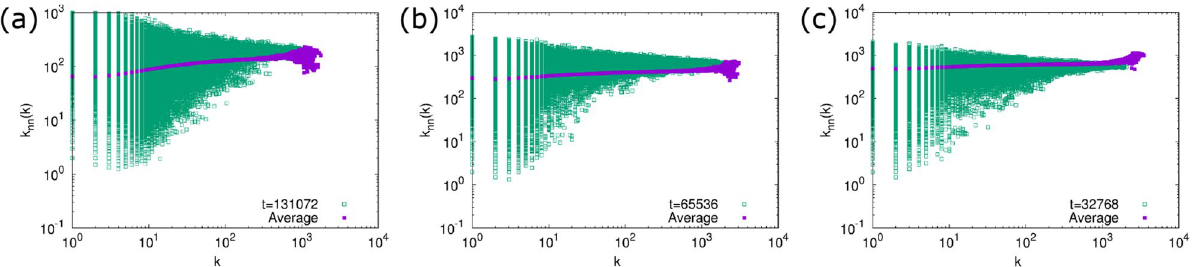
Figure 4. The average number of links. ( a ) δ the right-hand-side of Eq. (2). The data are averaged over 100 trials.